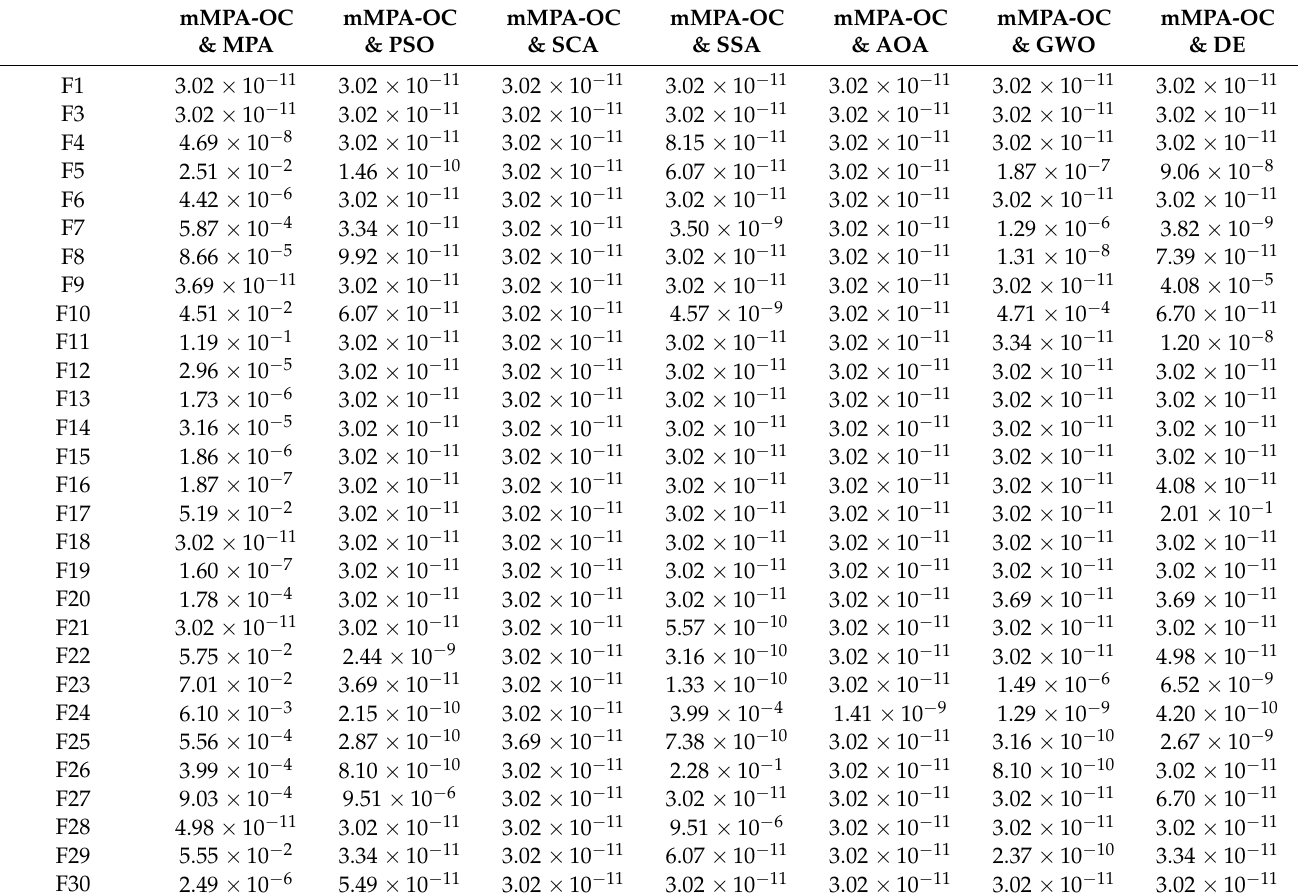
Table 6. p -values of the Wilson rank-sum test of mMPA-OC and the comparison algorithm in CEC-2017 (10 dimensions).